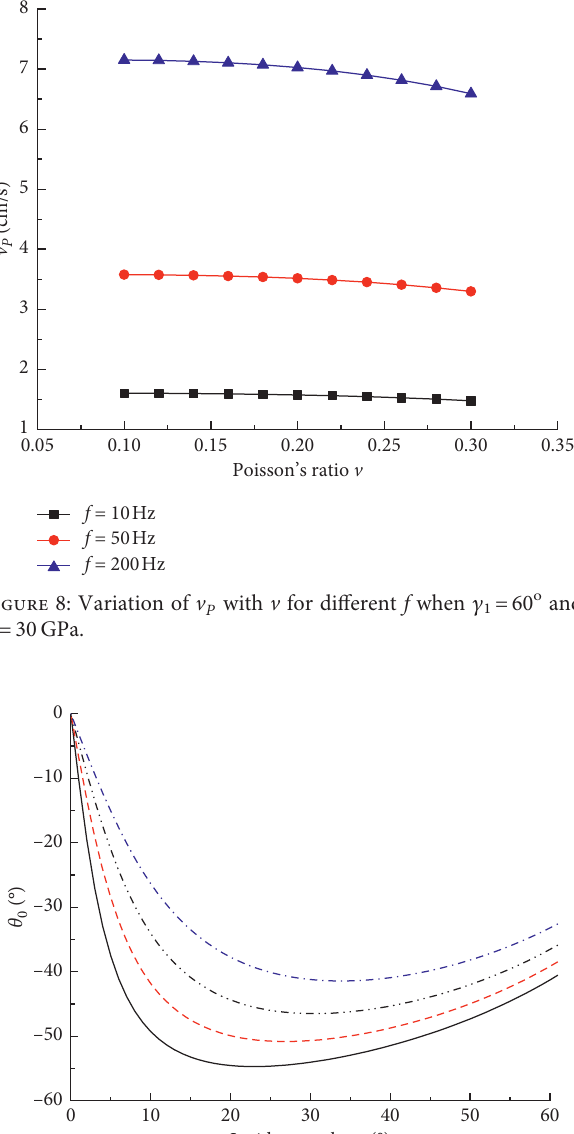
c 0 with 1 for different